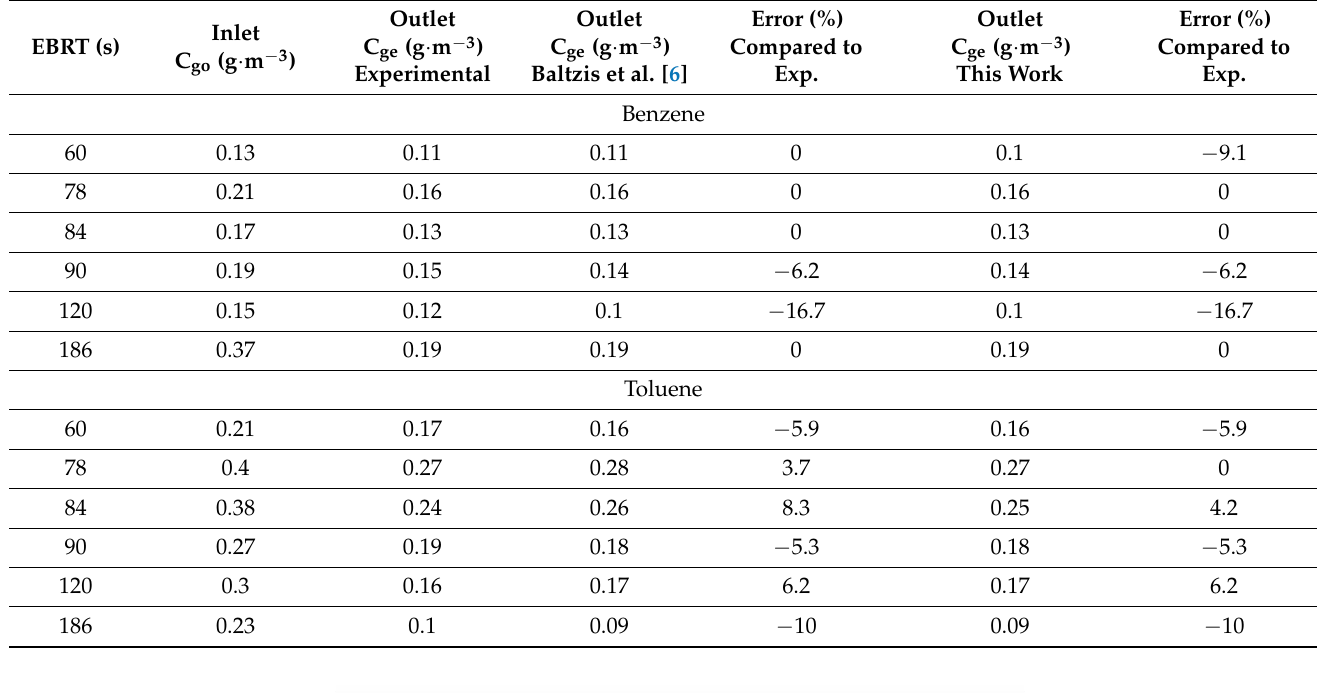
Table 2. Model validation and comparison with the experimental data from Baltzis et al. [6].